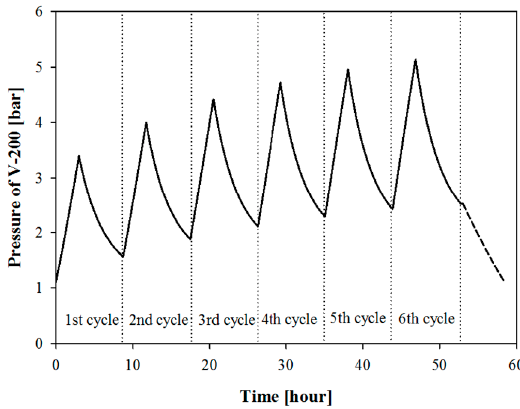
Figure 15. Pressure of BOG inlet (DS-Case VI) and initialization and ventilation over six cycles.